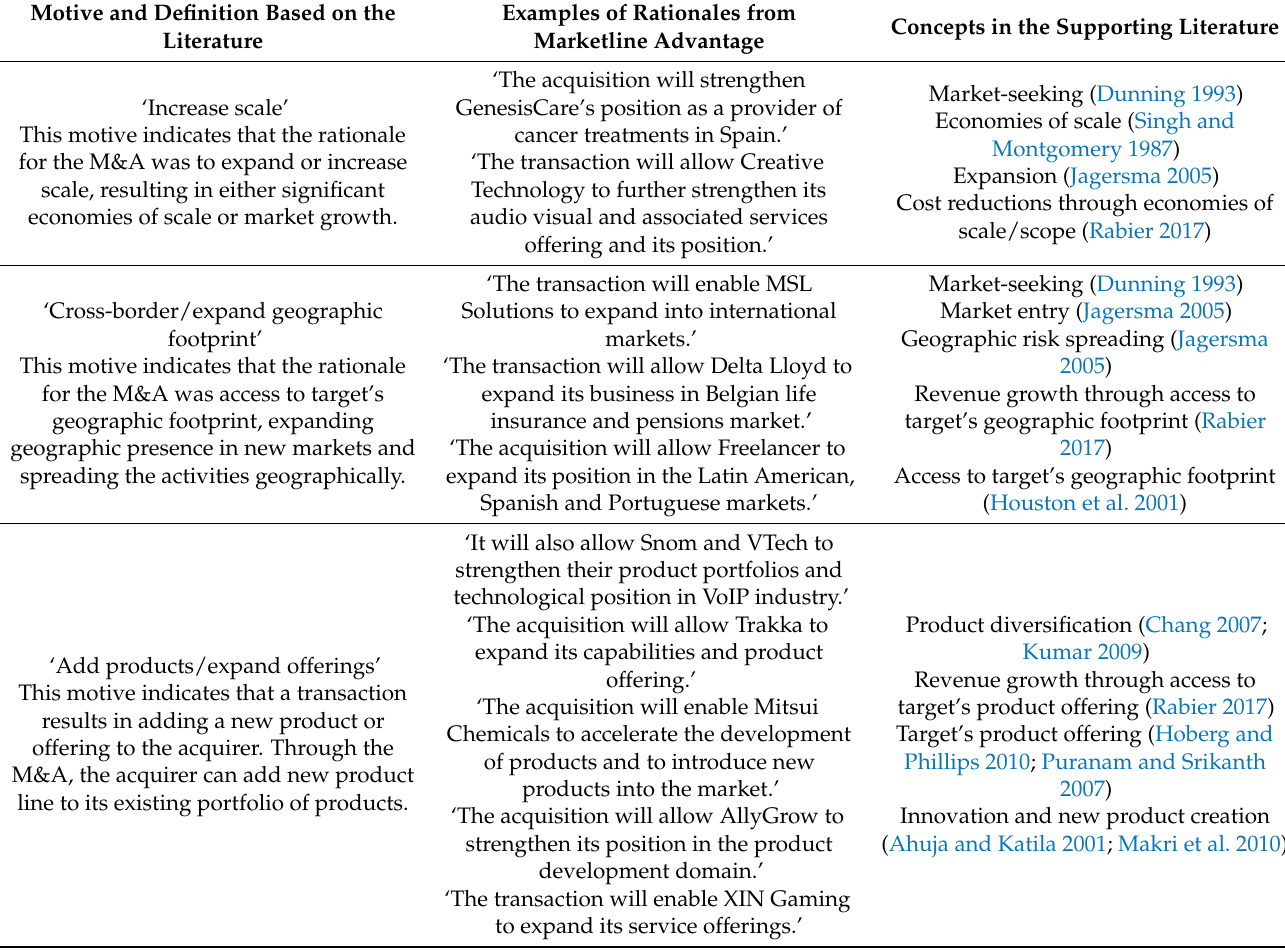
Table A2. Definitions of main motives (dependent variable) and supporting literature.